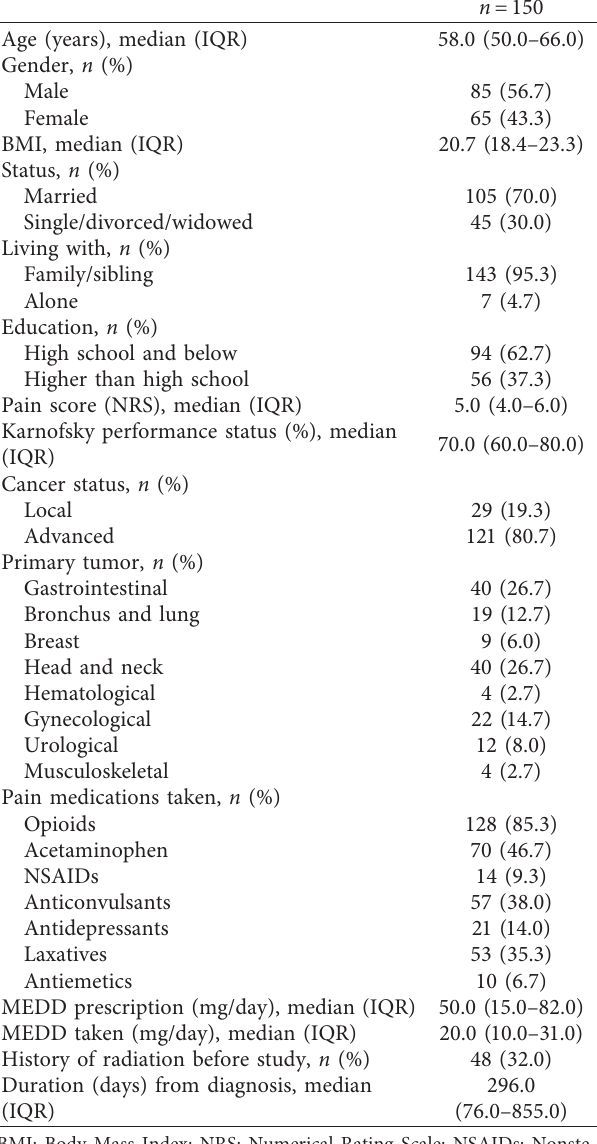
Table 1: Baseline demographic